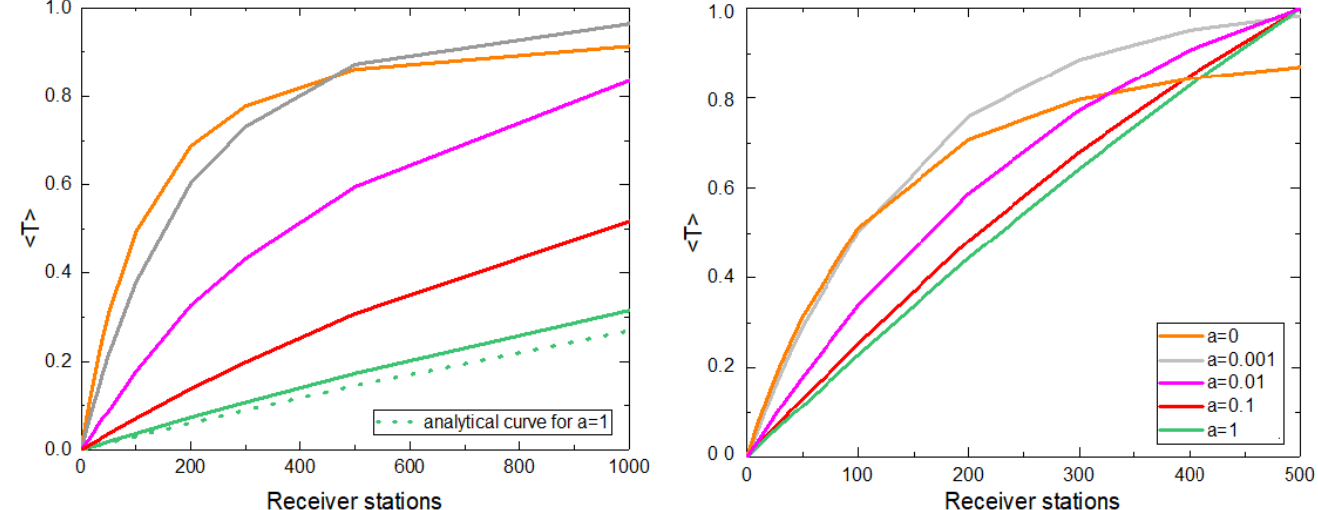
Figure 2. ( Left ) Average number of transmitted packages per unit time per animal (cid:104) T (cid:105) vs. the number of receiver stations for the random distribution case of the receiver stations. The dotted green curve indicates the theoretical probability of the transfer function for a = 1. ( Right ) (cid:104) T (cid:105) vs. the number of receiver stations for the case where the receiver stations are distributed within the homes. In both graphs we show results averaged over 100 realizations, 20,000 time steps were considered, N = 500, v = 0.001, and r = 0.01. Each curve corresponds to a different value of a = 0, 0.0001, 0.01, 0.1, and 1 according to the color shown in the